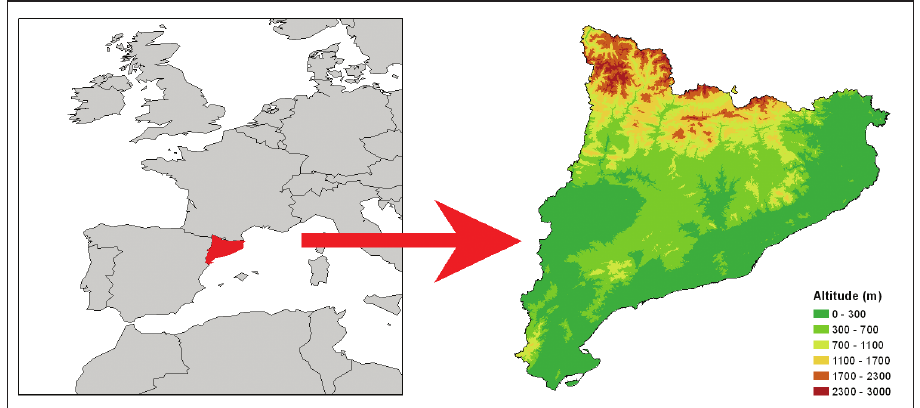
Figure 1. Location of Catalonia and elevation map of the study